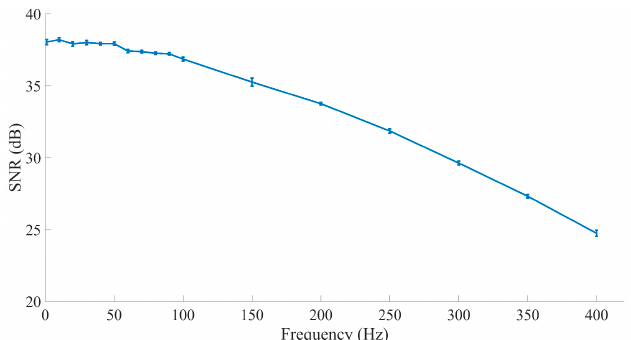
Figure 9. The SNR of the generated signal. The electrophysiology sensors for the EEG signals contained a first-order lowpass filter that removed high-frequency signals that we do not focus on in EEG. The blue line represents the SNR of each acquired signal across frequencies.